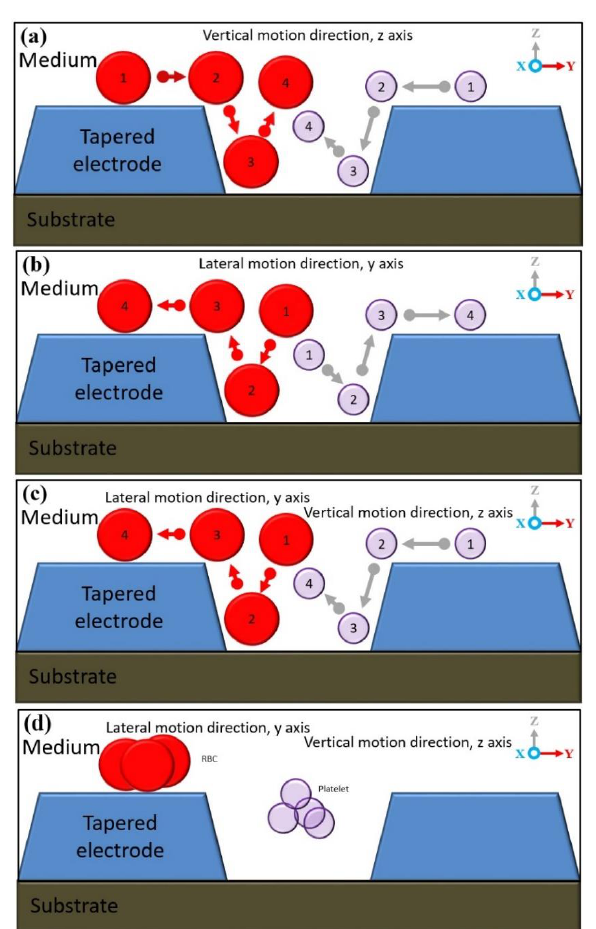
Figure 13. The separation of RBC and platelets: ( a ) Sequencing of the separation at the low input frequency region where both RBC and platelets were exposed to N DEP vertical repulsion at the z-axis; ( b ) at the high input frequency region where RBC and platelets were exposed to P DEP lateral attraction at y-axis; ( c ) within the fxo input frequency region where fadj produced different polarisations between the RBC and platelets, P DEP lateral attraction at the y-axis and N DEP vertical repulsion at the z-axis, respectively; and ( d ) separation at two different locations, which are RBC at the top surface microelectrodes and platelets between two